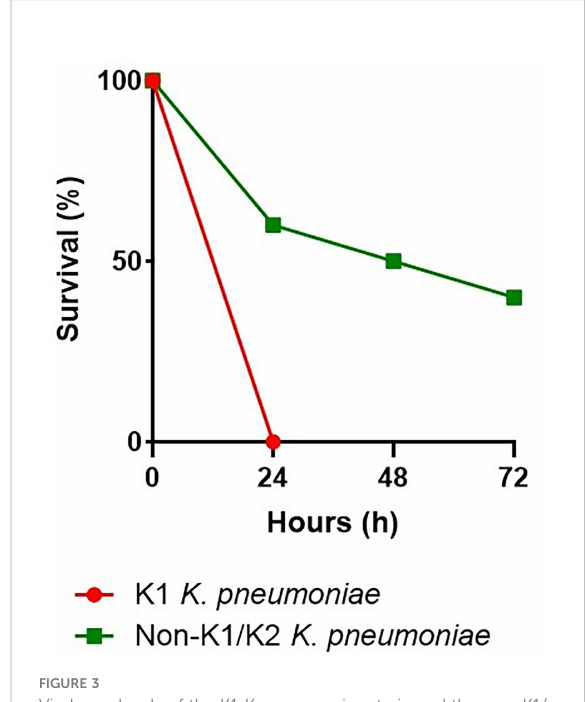
FIGURE 3 Virulence levels of the K1 K. pneumoniae strain and the non-K1/ K2 K. pneumoniae strain in the G. mellonella infection model. In G. mellonella , the survival rate after an injection of 10 6 CFU with the serotype K1 was 0% at 24 hours, compared with the serotype non-K1/K2, which was 60%, 50%, and 40% at 24, 48, and 72 hours,